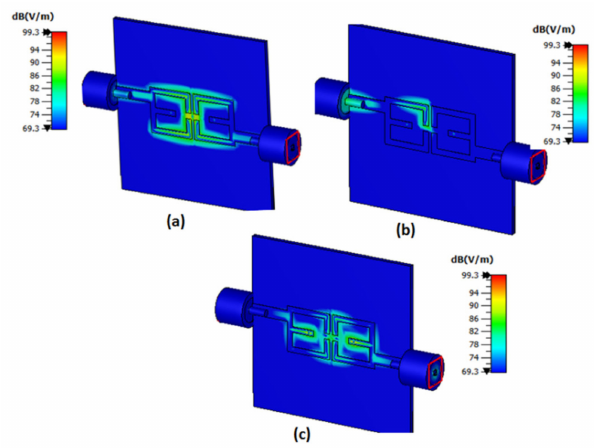
Figure 18. The electric field results of dual-band dual mode with 0 ◦ feed BPF. ( a ) at 3.5 GHz. ( b ) at 4.5 GHz. ( c ) at 5.5